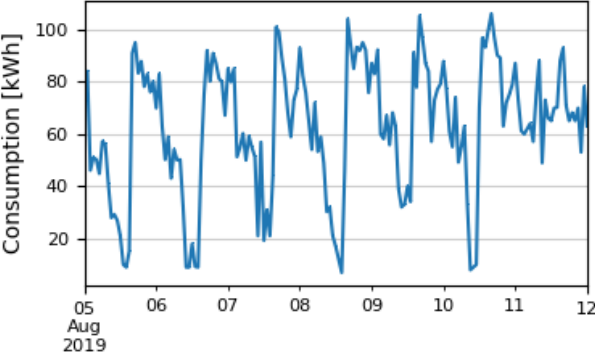
Figure 2. Single week seasonal